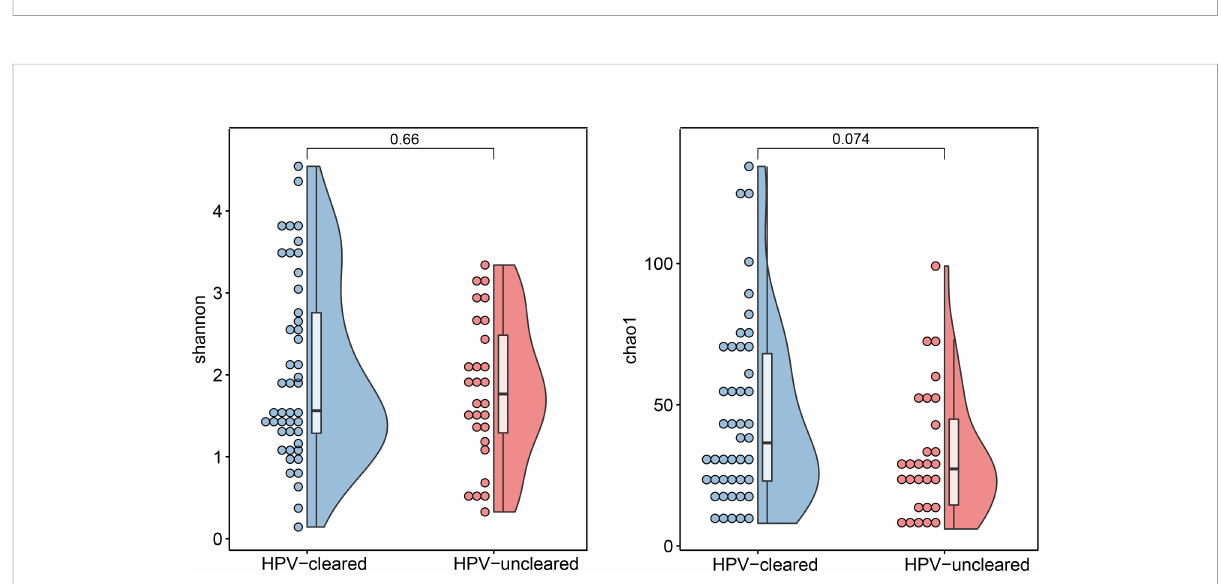
FIGURE 3 Microbial a -diversity analysis based on Shannon and Chao1 index in the HPV-cleared and HPV-uncleared groups. Statistical signi fi cance between the groups was tested by Wilcoxon rank sum tests. HPV, human